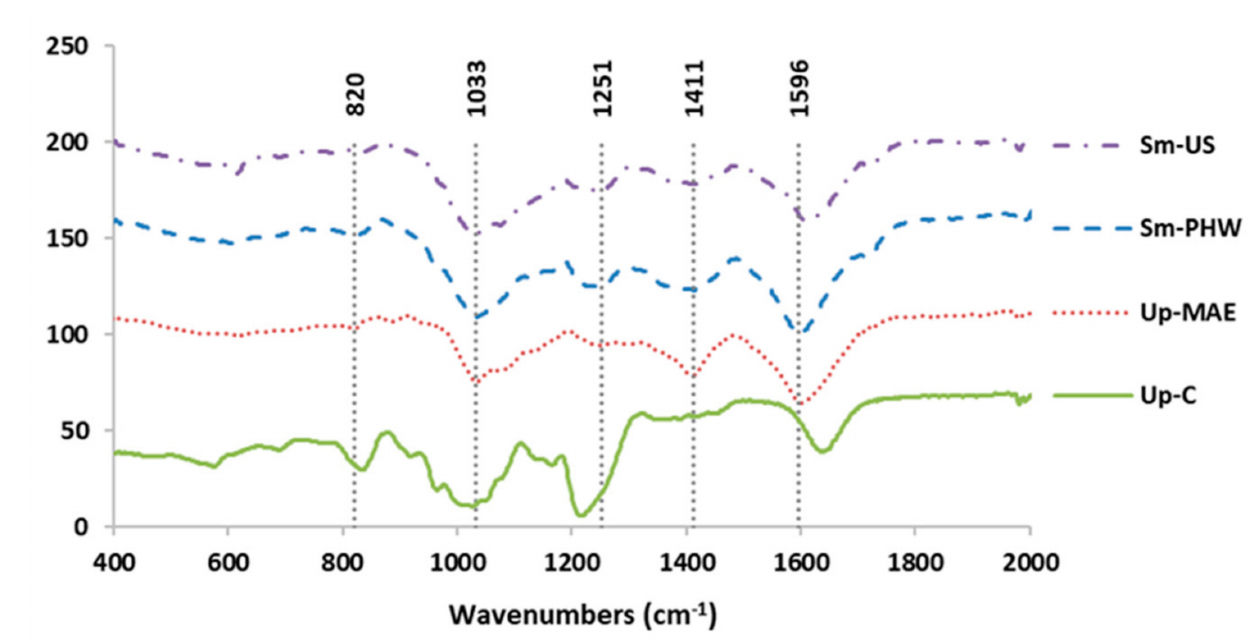
Figure 1. FTIR-ATR spectrum of crude fucoidan obtained from Sargassum muticum (Sm) from two extraction technologies: ultrasound-assisted extraction (Sm-US) and pressurized hot-water extraction (Sm-PHW), crude fucoidan from Undaria pinnatifida (Up-MAE), and commercial fucoidan from Undaria pinnatifida (Up-C) using microwave-assisted extraction